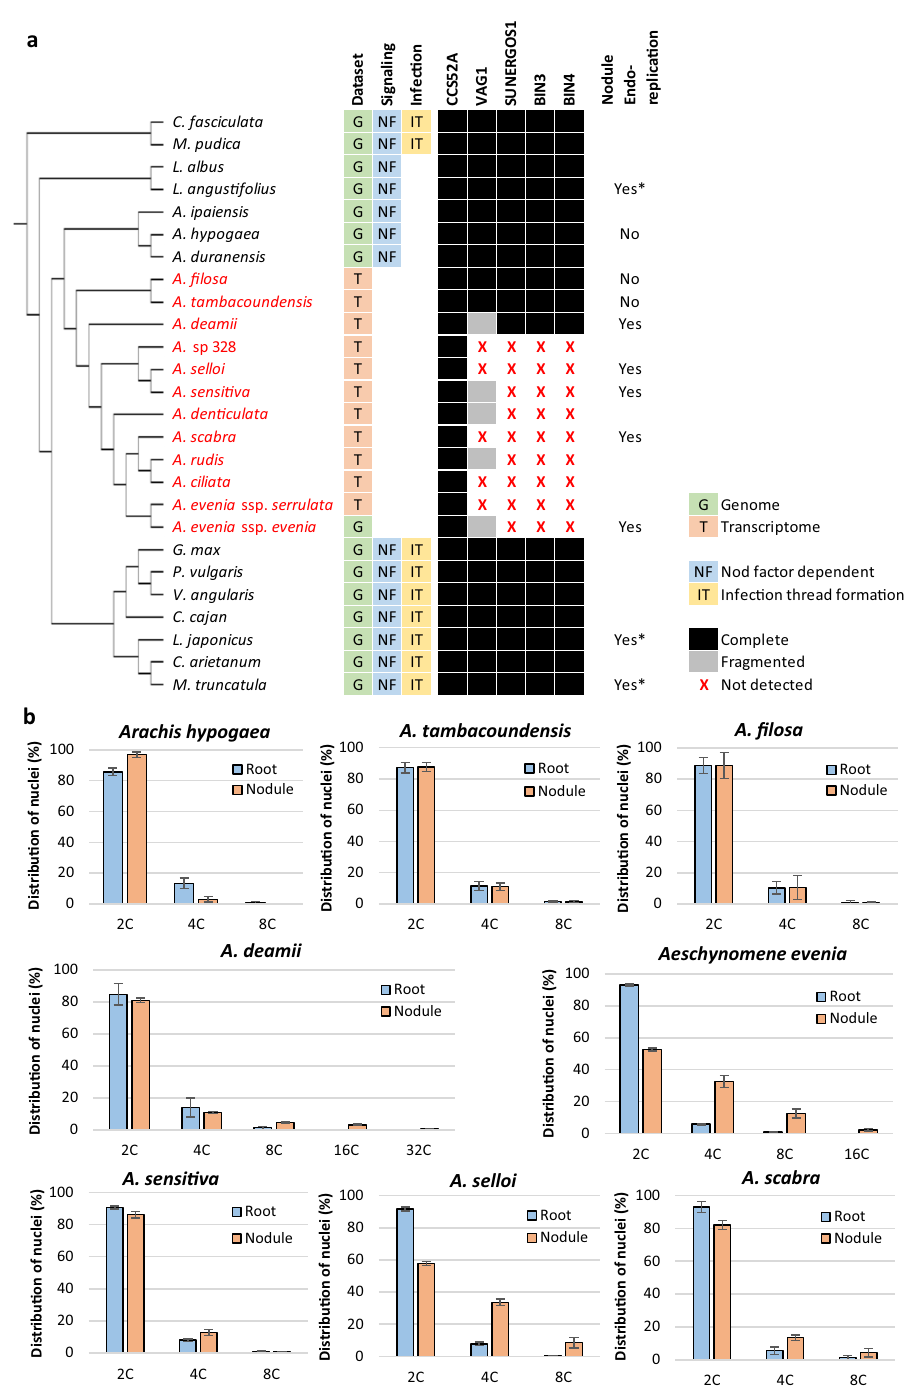
Fig. 3 Comparative analysis of endoreplication-mediated nodule differentiation. a Absence and presence of 5 genes involved in cell endoreplication during nodule differentiation, including the mitotic inhibitor CCS52A and components of the Topoisomerase VI complex, VAG1, SUNERGOS1, BIN3, and BIN4 in legume species. The maximum-likelihood tree containing Aeschynomene species (in red), members of the main Papilionoid clades, and two non- Papilionoid legume species was obtained by global orthogroup analysis. All bootstrap values (×1000) were comprised between 92% and 100% and so are not indicated for fi gure clarity. For the observed occurrence of nodule cell endoreplication, asterisks indicate data from the literature, others are from the present study. b Flow cytometric histograms of Arachis hypogaea and of several Aeschynomene species obtained by measurement of nuclear DNA content in root and nodule cells. Endopolyploidy was determined for at least 10,000 stained isolated nuclei per sample. Data are presented as mean values of three samples ±